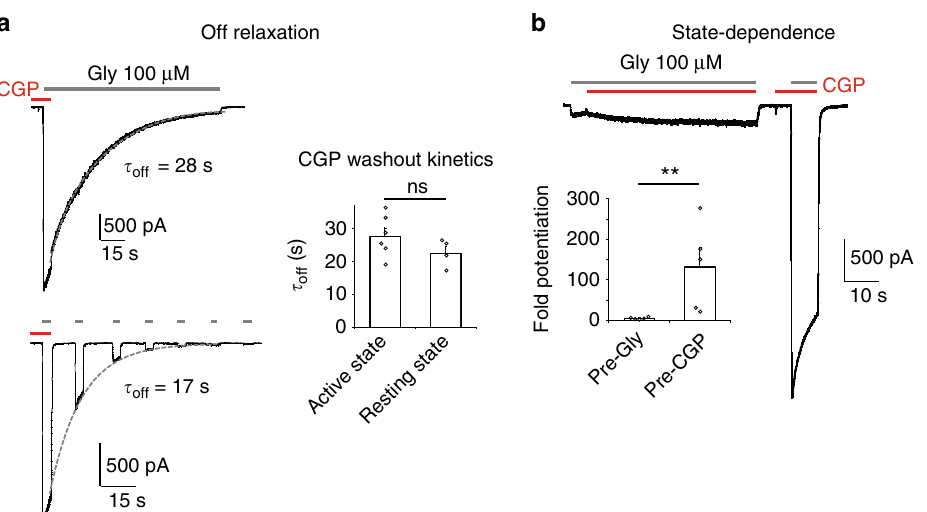
Fig. 2 Kinetics and activity-dependence of CGP-78608 potentiation at GluN1/GluN3A receptors. a CGP-78608 washout kinetics in the presence of continuous or pulses of glycine. CGP-78608 was applied at 500 nM. Bar graph: comparison of the CGP-78608 washout kinetics in the active (upper trace) or resting state (lower trace). n.s. P = 0.198, Student ’ s t -test; ( n = 4-6). b CGP-78608 potentiation is state-dependent. Potentiation by CGP-78608 (500 nM) is greatly reduced when the compound is applied after, rather than before, application of glycine (pre-Gly vs post-Gly, respectively). Bar graph: potentiation measured at steady-state. ** P = 0.008, Mann – Whitney test, ( n = 5). Data are mean ±